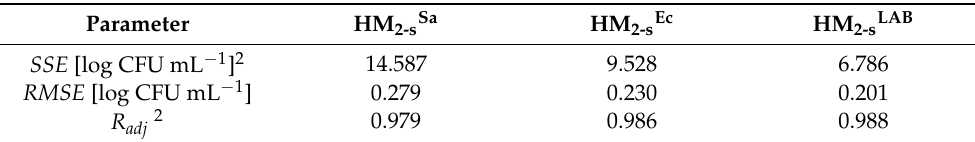
Number of data points: n Sa = 188; n Ec = 180; n LAB = 168. SSE is global sum of square, RMSE is root mean square error, and R adj 2 is adjusted determination coefficient.